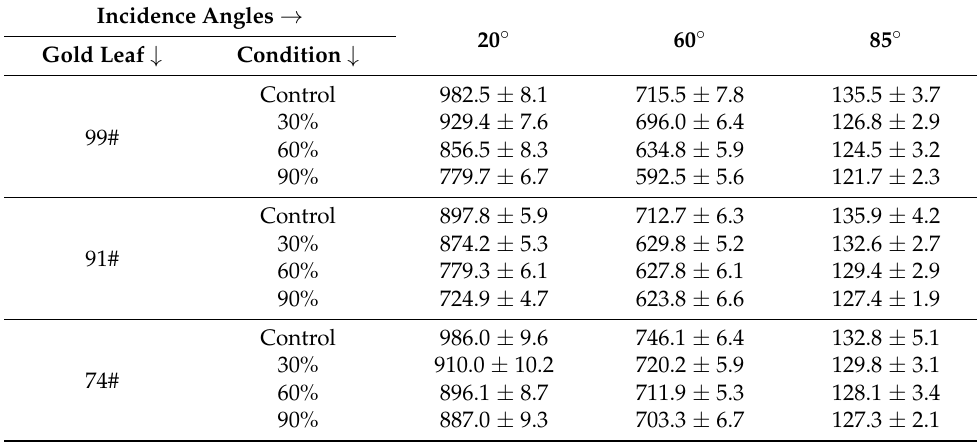
Table 1. Gloss of uncorroded and corroded samples (mean ± standard